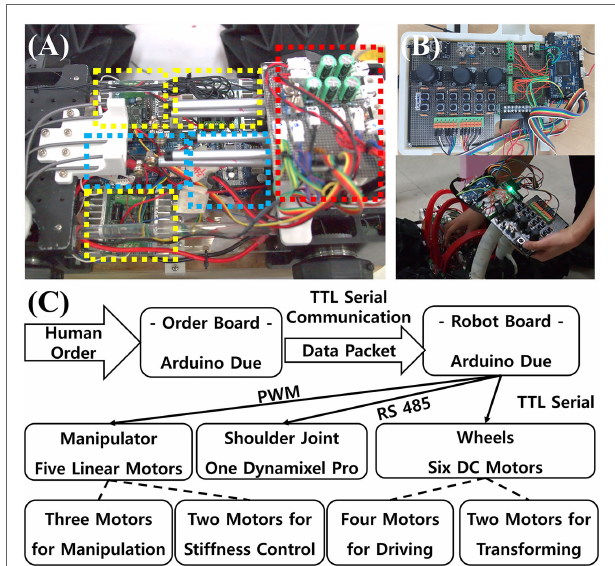
FigUre 8 | snUMaX circuit board and operator’s controller and schematic diagram of the control signal . (a) Yellow squares indicate the dual motor drivers. Blue squares indicate two MCU boards. The red square indicates the electric power distribution area. (B) Photo of the operator’s controller. Control signals were packetized and transmitted by TTL serial communication protocol to the MCU board on the robot. (c) Schematic diagram showing the control signal flow.